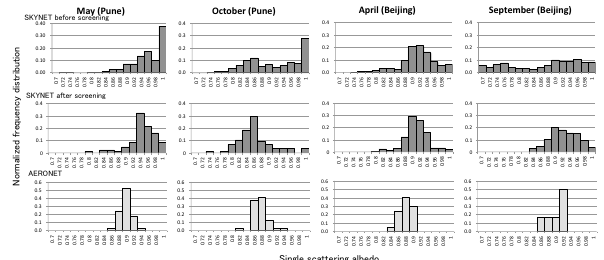
Fig. 15. Normalized frequency distributions of SSA from SKYNET and AERONET in May and October at Pune and in April and September at Beijing. Upper and middle panels are for SKYNET SSA before and after data screening, respectively, and lower panel is the figure for AERONET SSA.